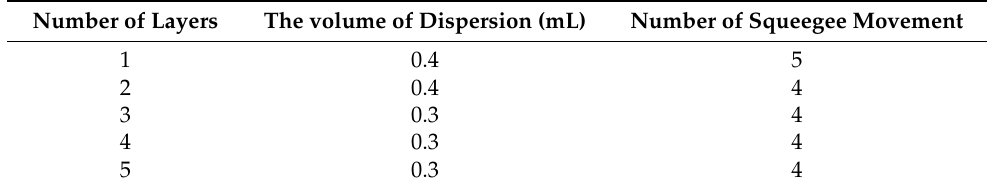
Table 3. Parameters of screen printing on CO–PES fabric using CNTs/CNC—1:1 and CNTs/CNC—